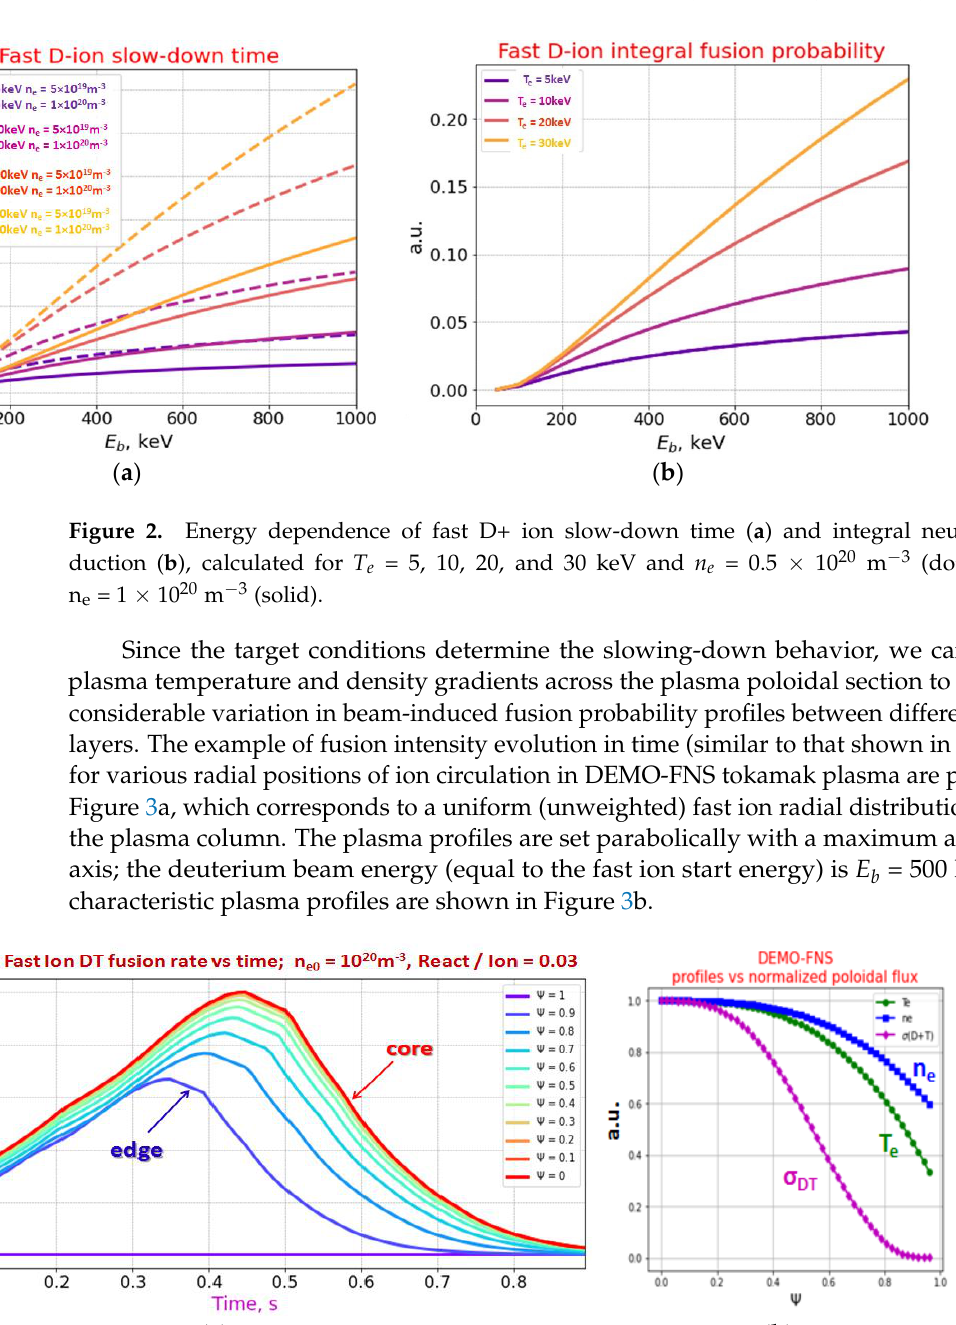
Figure 3. Fast ion fusion (and neutron production) rate evolution in time for different plasma layers ( a ); plasma characteristic profiles ( b ). Electron temperature T e , electron density n e , and thermal DT-fusion cross-section σ DT . Deuterium fast ion energy is E b = 500 keV; maximum values at plasma column axis T e (0) = 15 keV, n e (0) = 1 × 10 20 m −3 . Neutron emission rate grows while beam ions slow down, the peak in fusion reaction cross-section is achieved at different moments, defined by the local target density. The absolute neutron rate from a fast ion is proportional to the target density; this explains the rise of peak height from the plasma edge (Ψ = 1) towards the core (Ψ = 0).